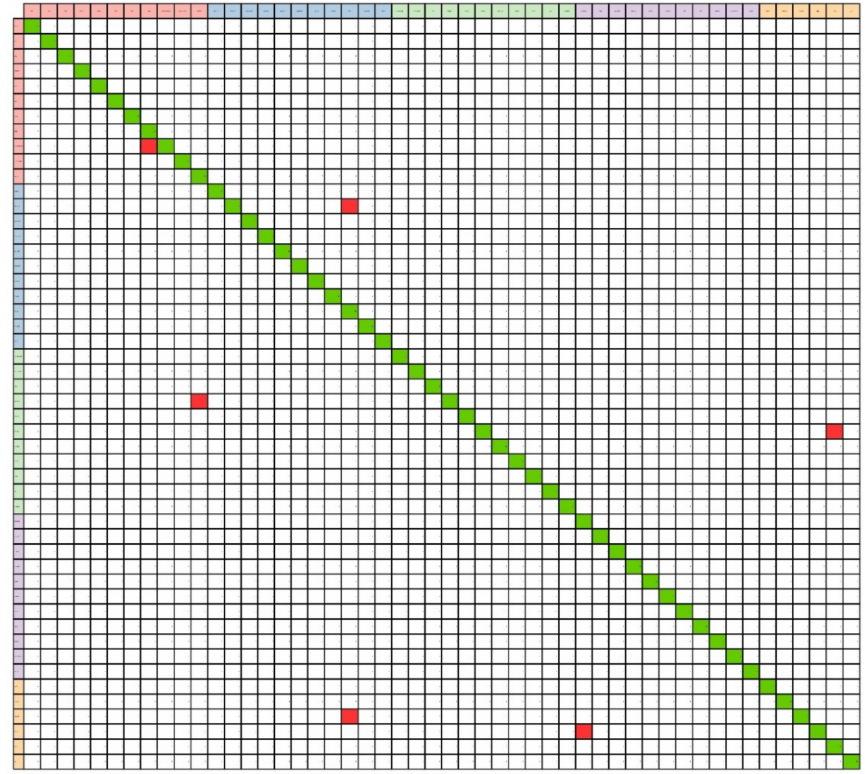
Figure A1. Confusion matrix of 50